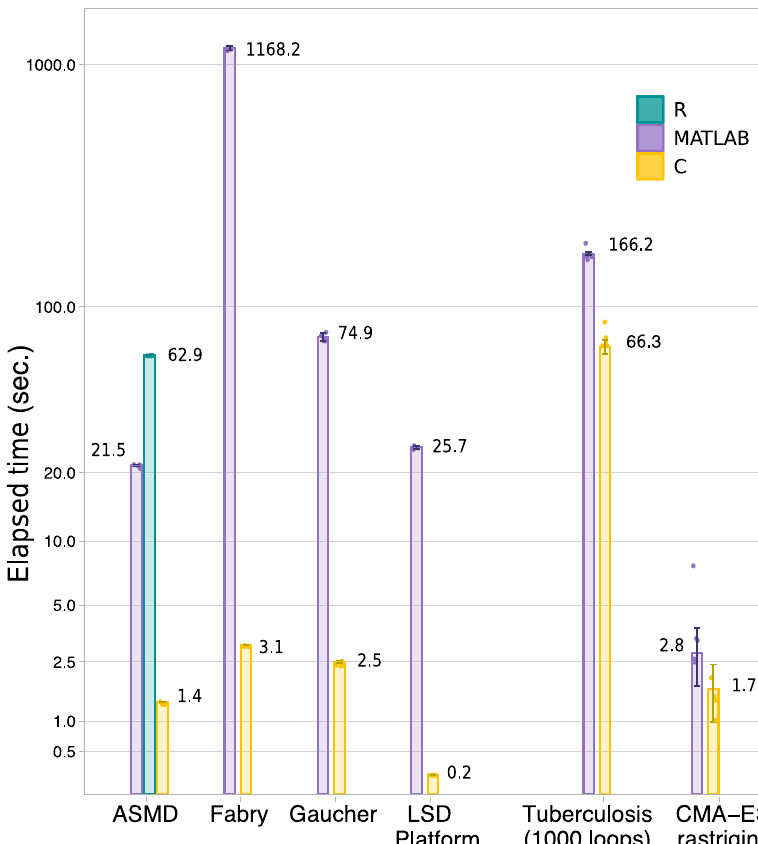
Fig. 2 Runtime analysis of the case studies and lysosomal storage disorder models (LSD). Median running times, with the corresponding median absolute deviation (MAD) of the original MATLAB implementations, and the QSPcc-generated C and R benchmark models. Each model was run 5 times. From left to right. The three clinical lysosomal disease models, bene fi tting of 15x, 377x, and 30x speed-ups each, that we integrated in the fourth LSD platform 11 , which ran 128 times faster in the intensive model optimization phase. The R simulation is consistently slower than MATLAB. It is provided only for ASMD, one of the three representative in-dept case studies part of the LSD platform, as a demonstration of the compiler ’ s ability to work with multiple languages. On the right, the two in-depth case studies described in the text for Tuberculosis agent-based modeling and CMA-Es evolutionary optimization computed the relative error using the following formula.